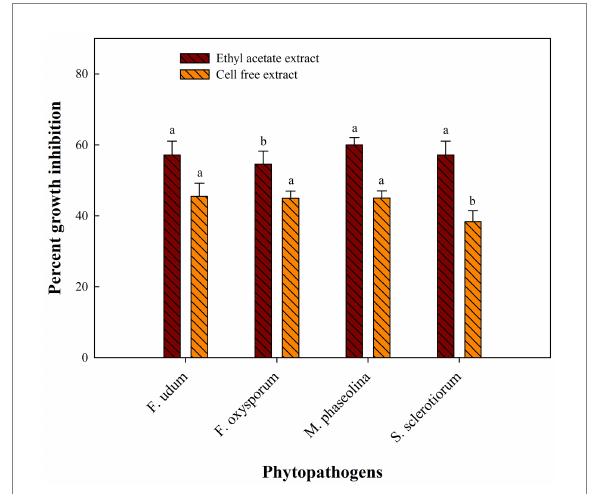
FIGURE 6 Antifungal activity (% inhibition) of Streptomyces araujoniae TN11 metabolites extracted in ethyl acetate and cell-free extract against different fungal pathogens. The data are the mean of three replicates ± standard error, within each graph, values followed by the same letter are not significantly different ( p ≤ 0.05) according to Duncan’s multiple range test.